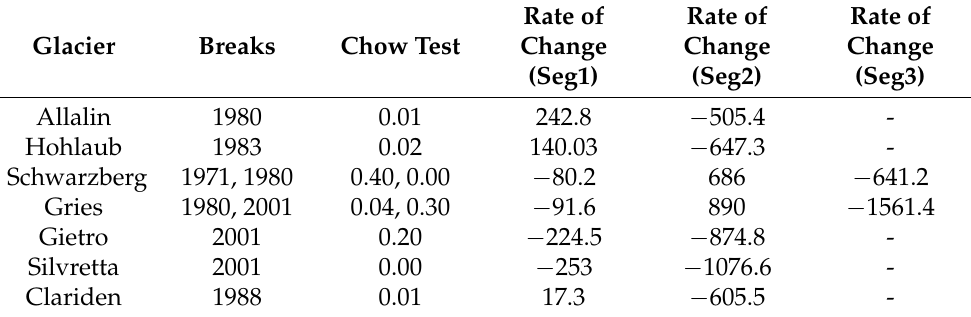
Table 3. Structural break points of Ba and the pre/post-break change coefficients (mm w.e.).